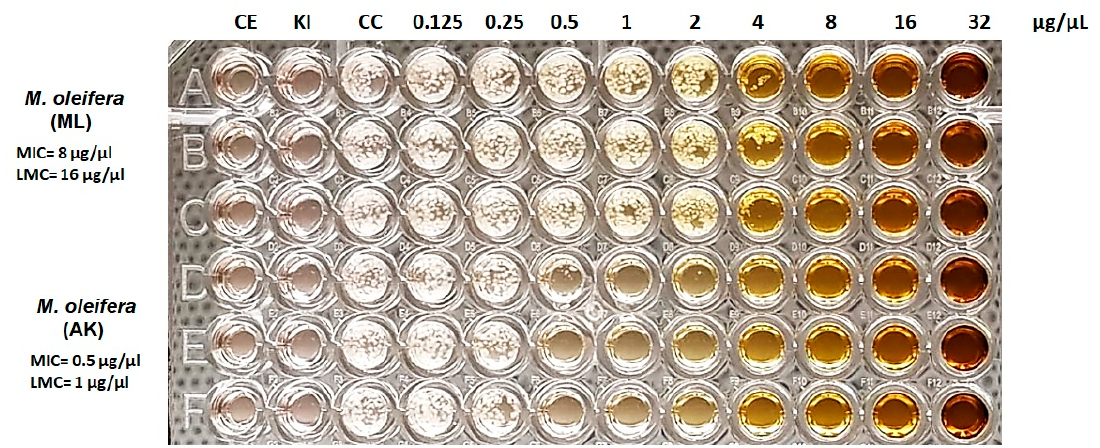
Figure 1. Determination of the minimum inhibitory concentration of extracts of Moringa oleifera . Growth of S. schenckii at 72 h in increasing concentrations of Moringa oleifera extracts. CE: sterility control, CKI: potassium iodide control, CC: growth control, MIC: minimum inhibitory concentration, LMC: minimum lethal concentration.